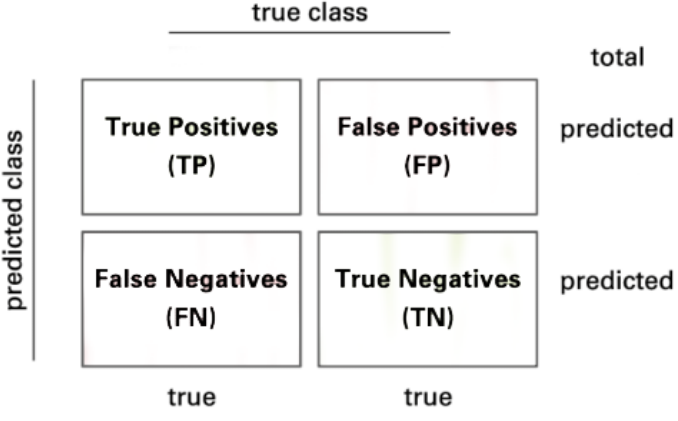
Figure 8. Confusion